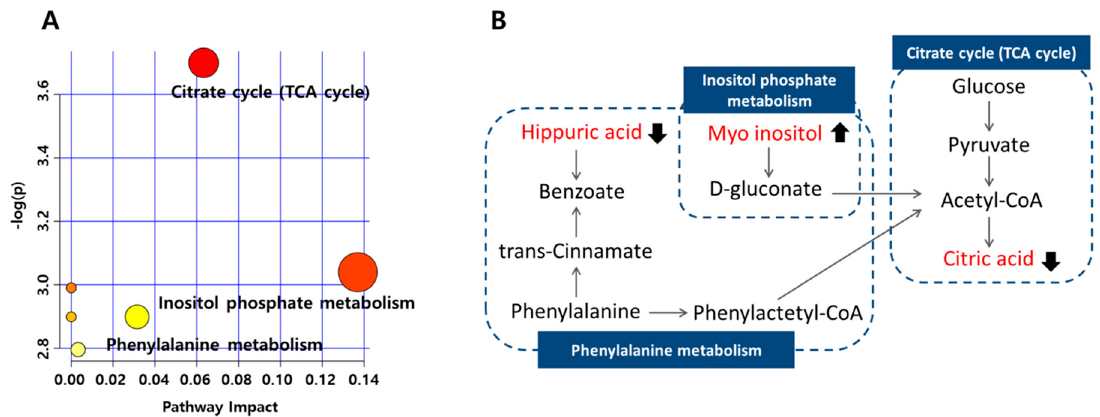
Figure 3. Pathway analysis of metabolites associated with metformin non-response at baseline, according to the MetaboAnalyst (MetPA). ( A ) Metabolome pathways of the citric acid, myoinositol, and hippuric acid; the larger the value of -log(p), the more red points are represented in the plot (based on p-values from pathway enrichment analysis), and the node radius was based on their impact value (impact values from pathway topology analysis). ( B ) Symbols: filled arrow indicates significant difference in non-responder groups at baseline.